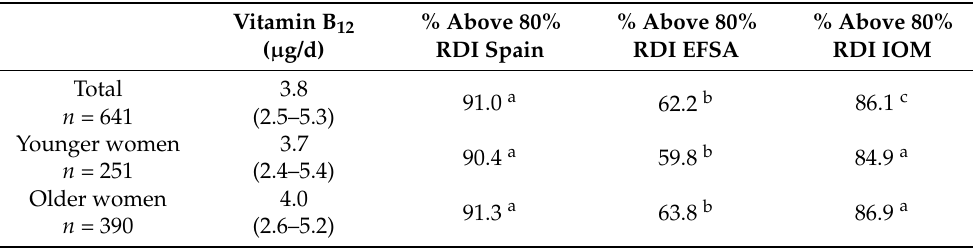
Table 7. Vitamin B 12 intake and prevalence of adequacy (percentage of population above 80% RDI) in women of childbearing age ANIBES study.